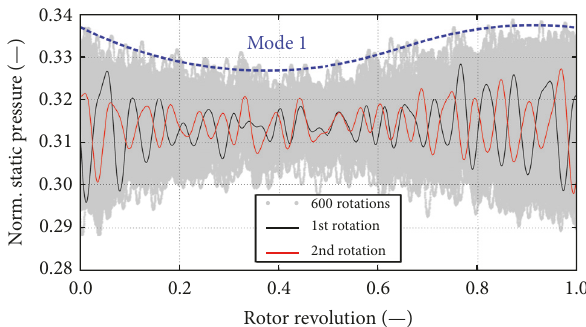
Figure 8: Casing pressure signal of 600 rotor revolutions stacked and superposed on two example revolutions (low-pass filtered at 5 kHz, below BPF) at a location above rotor 1 close to the